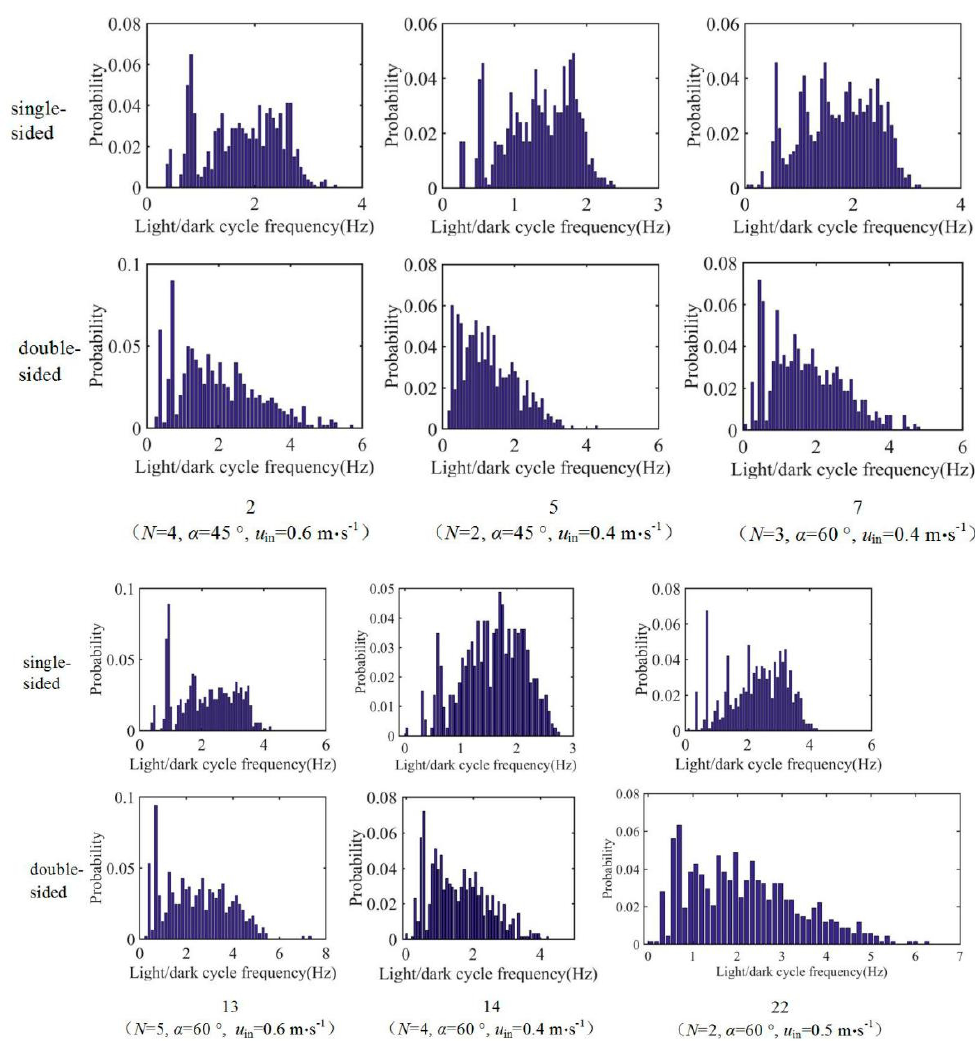
Figure 9. Probability densities of the L/D cycle frequency for tests 2, 5, 7, 13, 14, and 22.